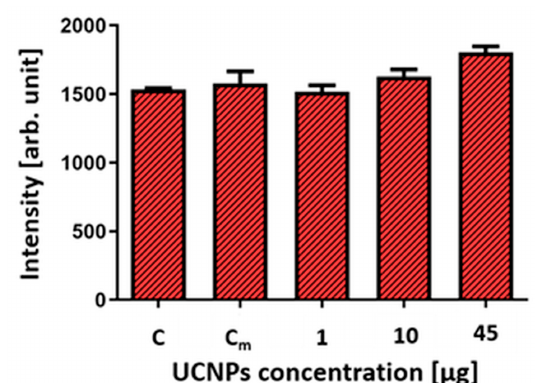
Figure 7. Effect of UCNPs on cell death of OHSCs. Each value is the mean obtained from four replicates for each variant. Statistical analysis was performed using one-way ANOVA with Tukey’s test, n = 4; p > 0.05. C—Control, the OHSCs untreated with UCNPs and medium; C m —control, OHSCs treated only with the medium.